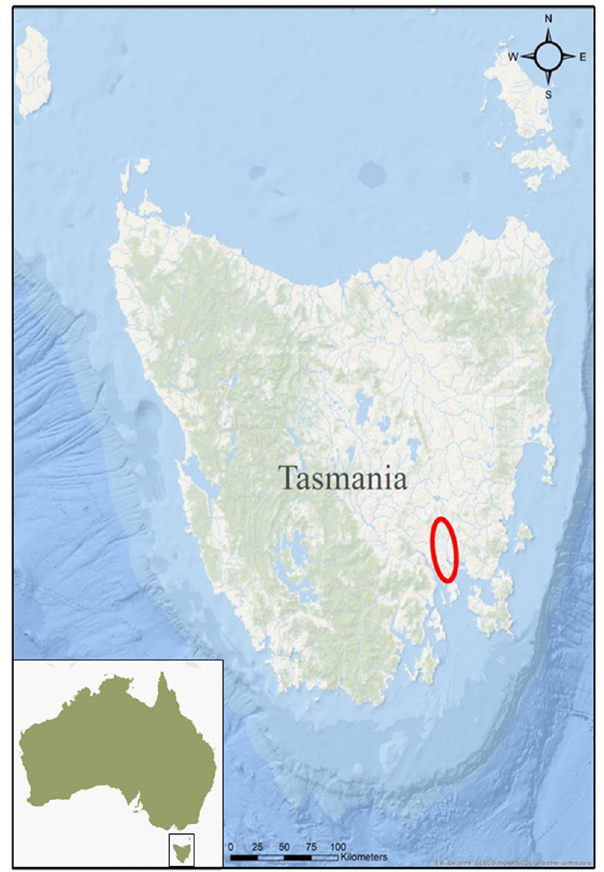
Figure 2. Map of Tasmania, with the Coal River Valley in the red circle.